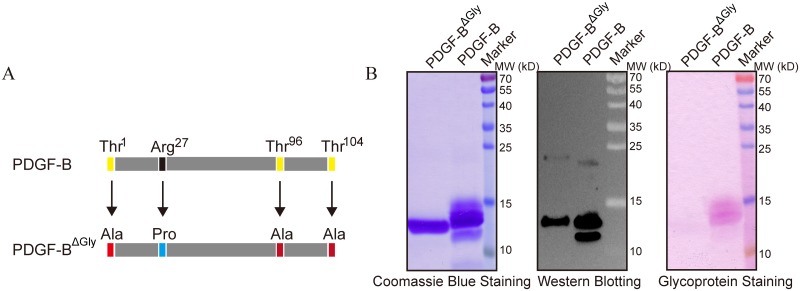
Mutation of the putative O-glycosylation sites in rhPDGF-BB.(A) Schematic representation of point mutations in PDGF-BB. (B) Purified wild-type PDGF-BB and PDGF-BBΔGly mutant were separated by reducing SDS-PAGE and analyzed by Coomassie Blue staining (left panel), western blotting (middle panel), and glycosylation staining (right panel). A single homogeneous band could be observed after western blotting and Coomassie Blue staining, while no band was detected by glycosylation staining of the mutant.